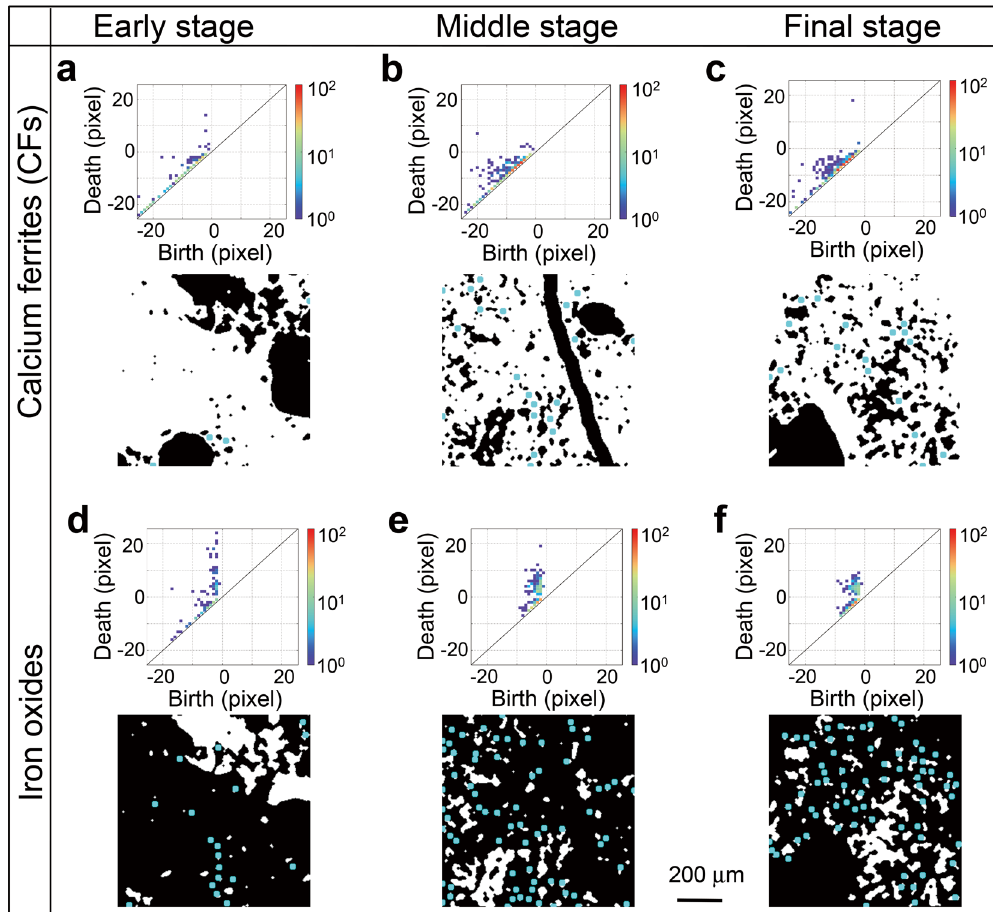
Figure 3. Examples of phase maps (bottom image in each panel) and the corresponding persistence diagrams (upper image in each panel) for ( a – c ) calcium ferrites and ( d – f ) iron oxides during the ( a , d ) early (S-1), ( b , e ) intermediate (S-2), and ( c , f ) final (S-3) stages of reduction. The blue circles show the centres of the representative shapes in each image (calculated using a PCA analysis) that became predominant as the reduction